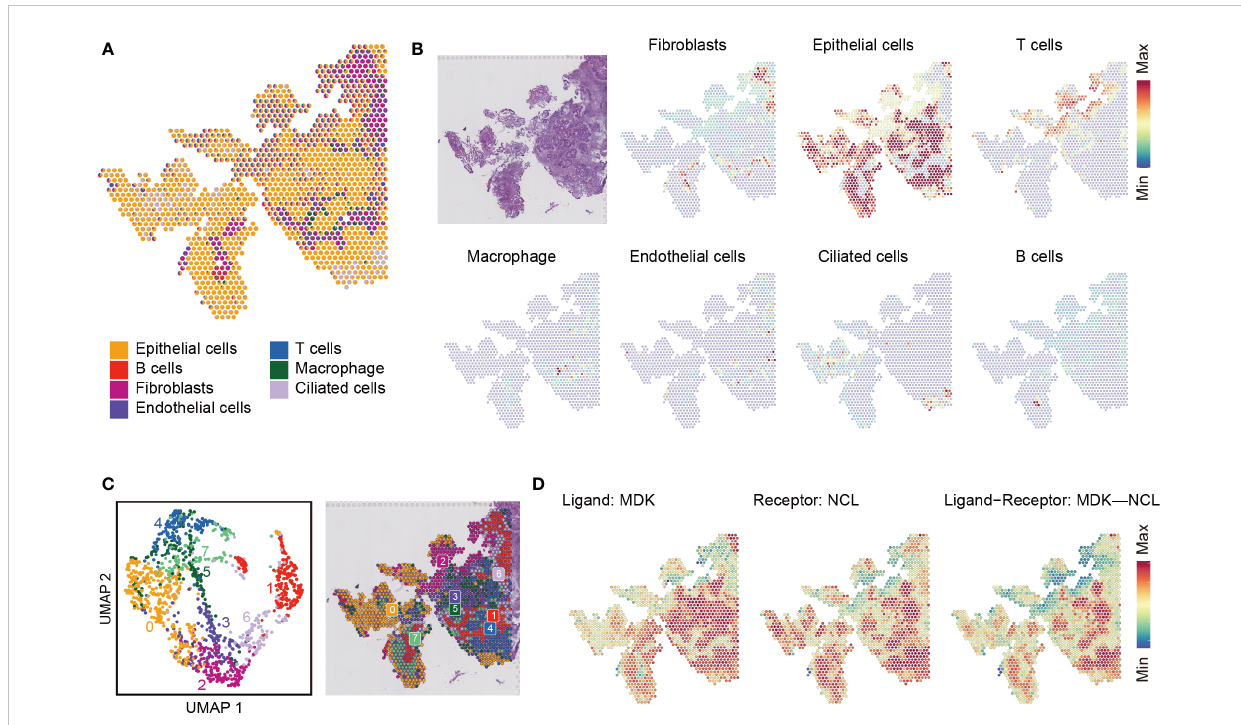
FIGURE 5 Cell type mapping on endometrial carcinoma tissue slice. (A) Spatial scatter pie plot representing the proportions of the cells from the reference atlas within capture locations in the endometrial carcinoma tissue. (B) Predicted proportion within each capture location for the cell types. (C) Unbiased clustering of spatial transcriptomic (ST) spots (left) and local microenvironment estimated from ST dataset by limiting cell-cell interactions to those within local neighborhoods, yielding a ‘ niche ’ atlas for each transcriptomic spot (right). (D) MDK-NCL signaling